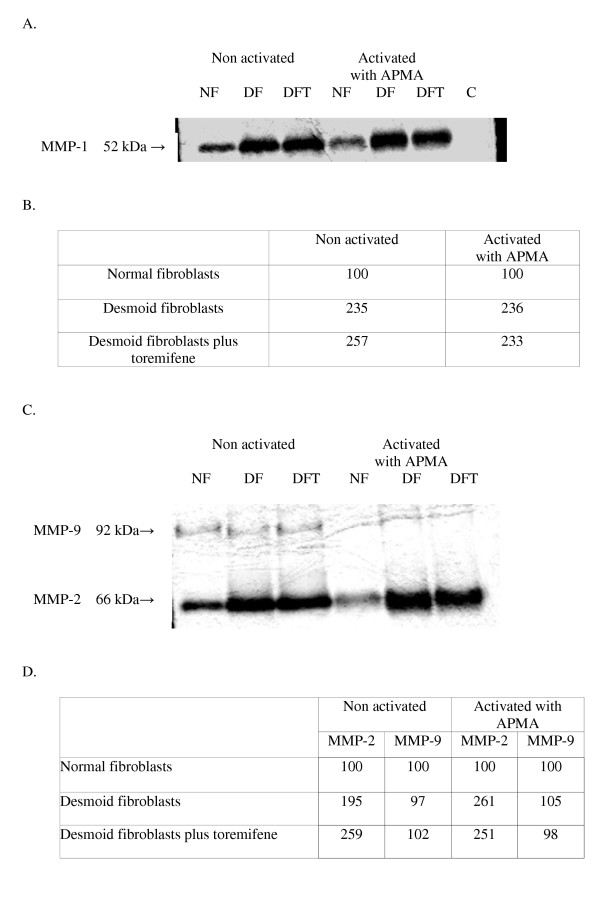
Zymogram of media from normal fibroblasts, desmoid fibroblasts, desmoid fibroblasts plus toremifene. Collagen zymogram. One set of samples was treated with APMA to activate the proenzymatic forms. Panel A. NF: normal fibroblasts, DF: desmoid fibroblasts, DFT: desmoid fibroblasts plus toremifene. In the same zymogram an aliquot of samples was activated with APMA: NF: normal fibroblasts, DF: desmoid fibroblasts, DFT: desmoid fibroblasts plus toremifene, C: trypsin. Similar results were obtained in four separate experiments. Panel B. The absolute counts, obtained by densitometric analysis, were converted to percentages assuming the level of normal fibroblasts as 100%. Gelatin zymogram. One set of samples was treated with APMA to activate the proenzymatic forms. Panel C. NF: normal fibroblasts, DF: desmoid fibroblasts, DFT: desmoid fibroblasts plus toremifene. In the same zymogram an aliquot of samples was activated with APMA: NF: normal fibroblasts, DF: desmoid fibroblasts, DFT: desmoid fibroblasts plus toremifene. Similar results were obtained in four separate experiments. Panel D. The absolute counts, obtained by densitometric analysis, were converted to percentages assuming the level of normal fibroblasts as 100%.